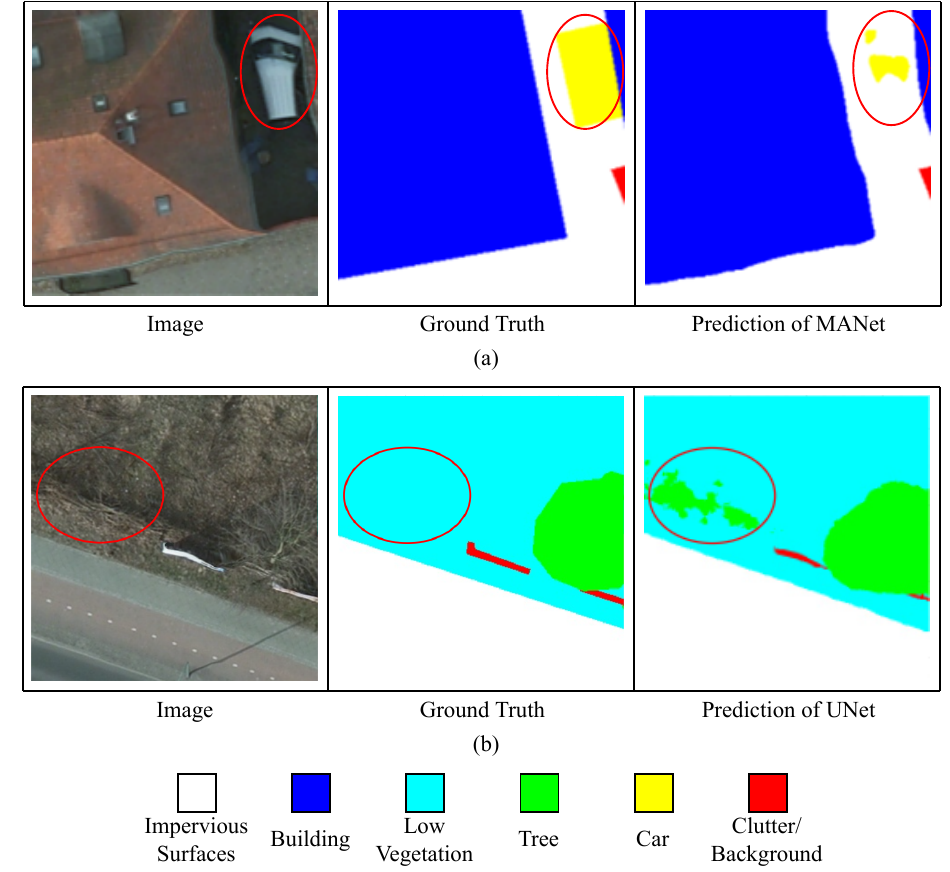
Figure 1. Examples of the prediction of cropped images of shape 256 × 256 from the Potsdam dataset using some popular semantic segmentation methods: ( a ) wrong prediction of the “car”, circled in red, using MANet; ( b ) wrong prediction of the “low vegetation”, circled in red, using